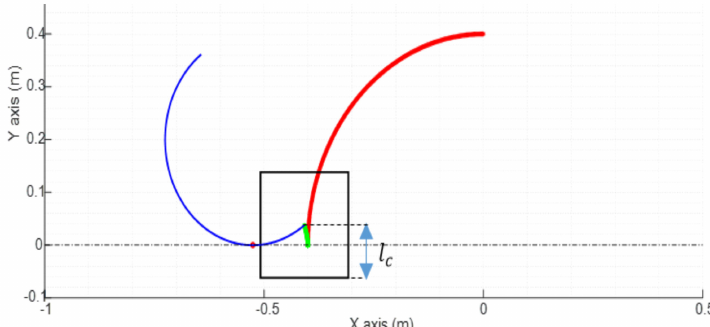
Figure 7. Schematics showing the system at a position where the chassis would be under the